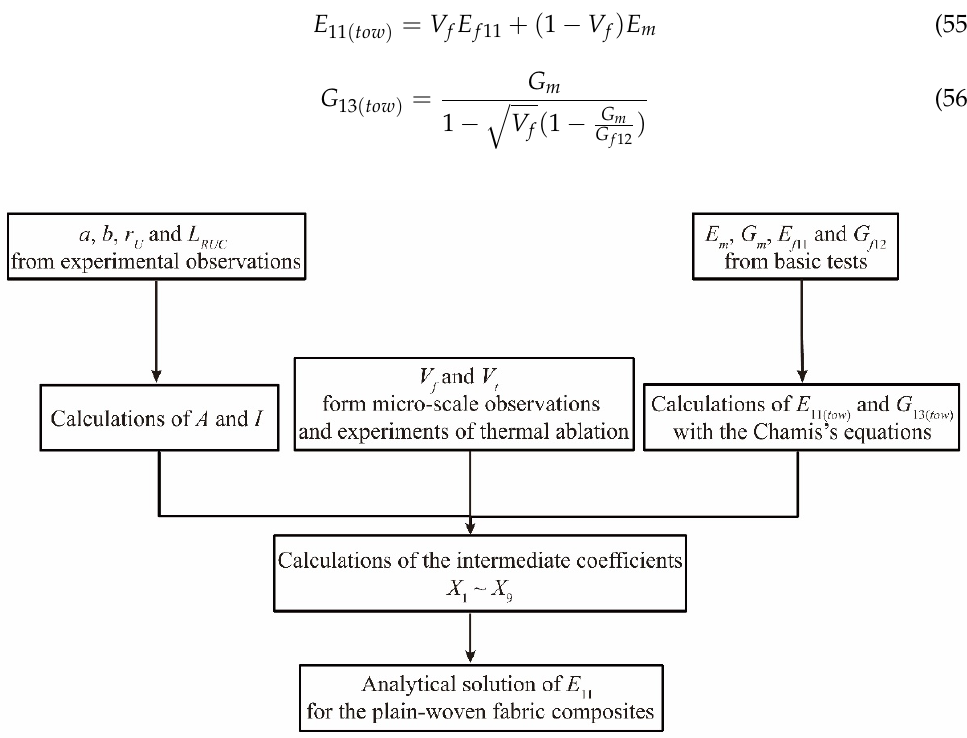
Figure 8. Flowchart of the analytical model for the uniaxial tensile modulus of the plain-woven fabric composites.